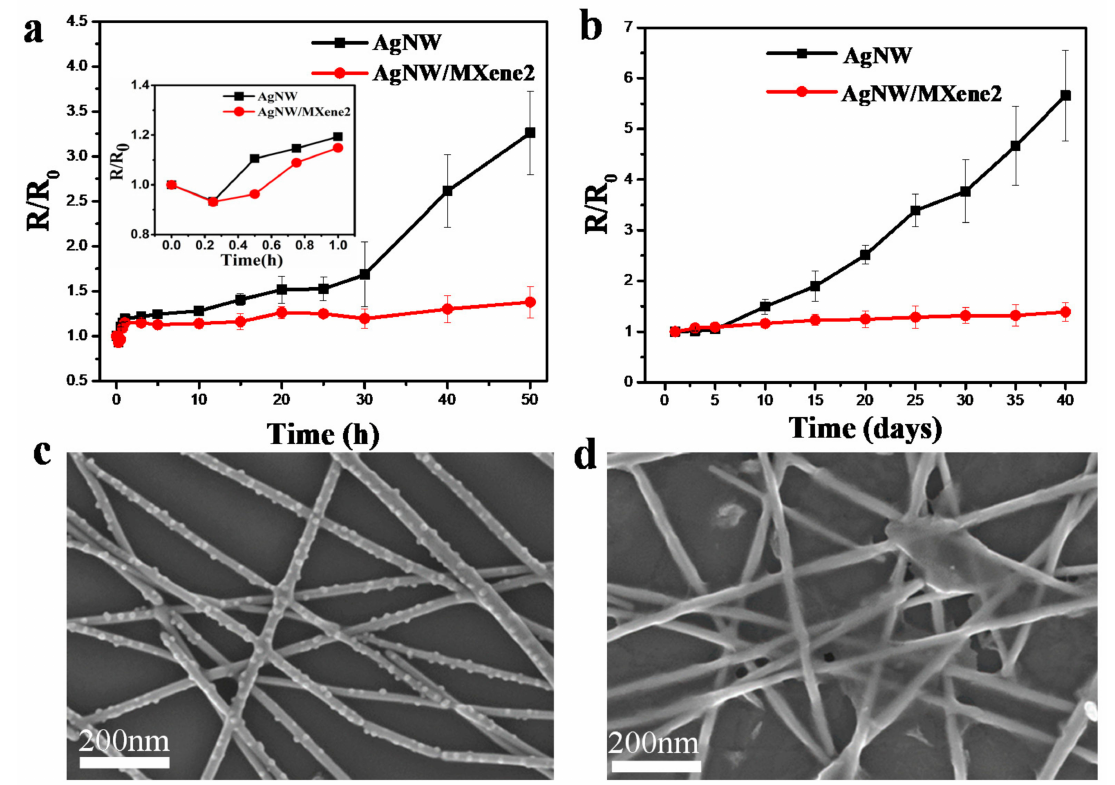
Figure 6. ( a ) Sheet resistance as a function of time at 100 ◦ C on a hotplate, and the curve in the first 1 h (inset). ( b ) Sheet resistance as a function of time in the ambient environment for 40 days. ( c , d ) SEM images of pristine AgNW and AgNW/MXene2 TCFs after exposed to air for 40